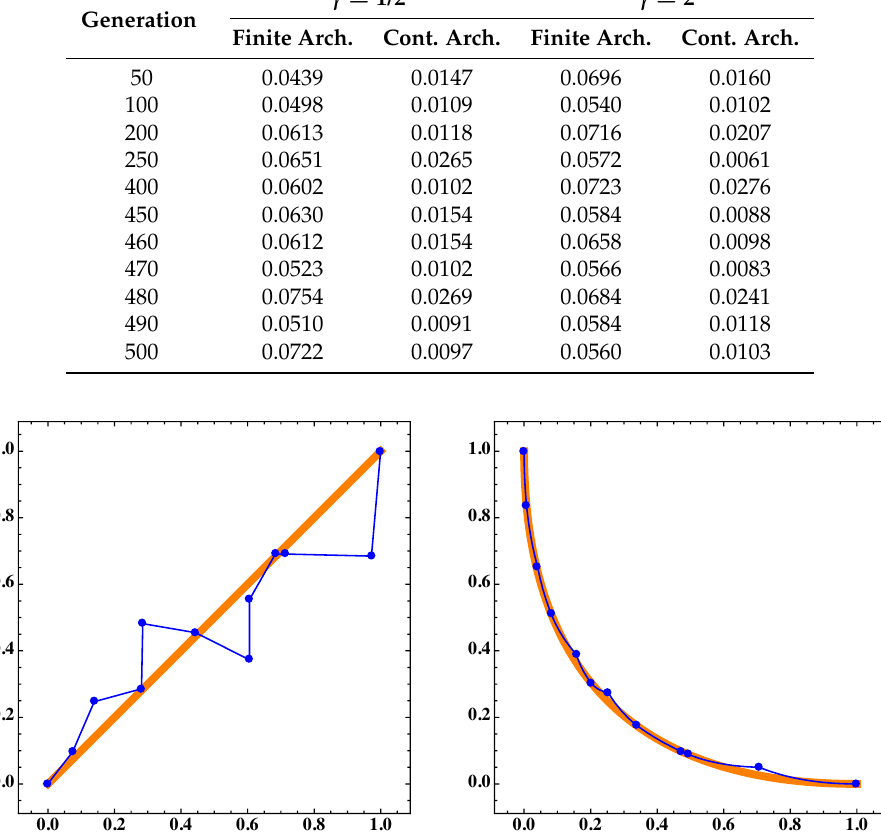
Figure 20. ( Left ) the blue dots A and the blue polygonal line are the discrete and continuous approximations, respectively, for the Pareto set and the orange thick segment is for the 410th generation of the MOEA/D algorithm of MOP (Equation (16)) for n = 2. ( Right ) corresponding sets F ( A ) and F ( B ) of the Pareto front for γ = 2.